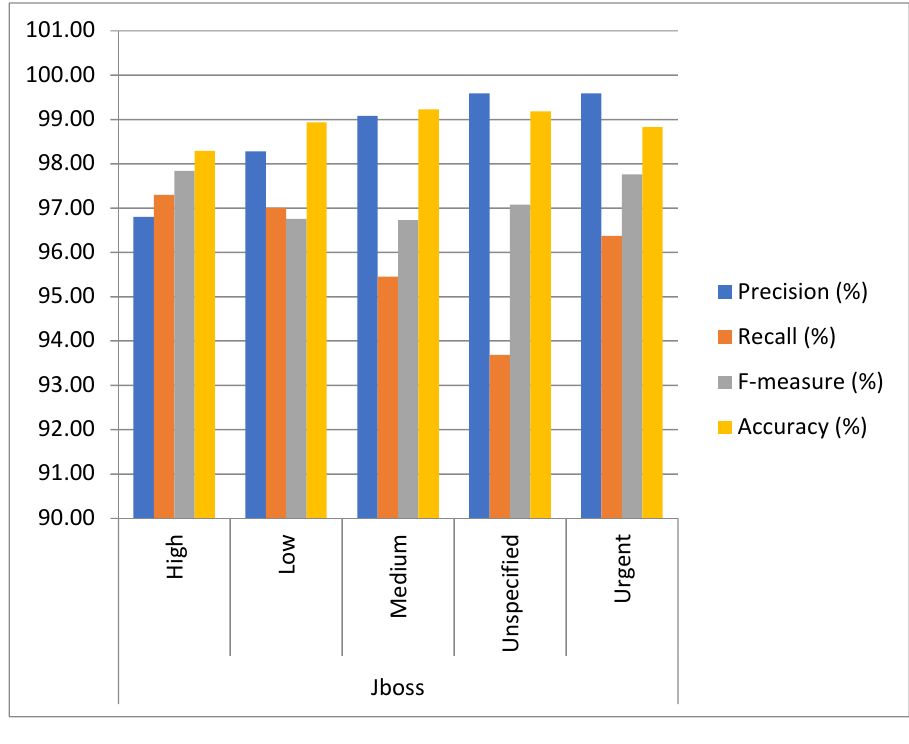
Figure 7. Results analysis of the proposed BCR on seven classes of the Eclipse Project .